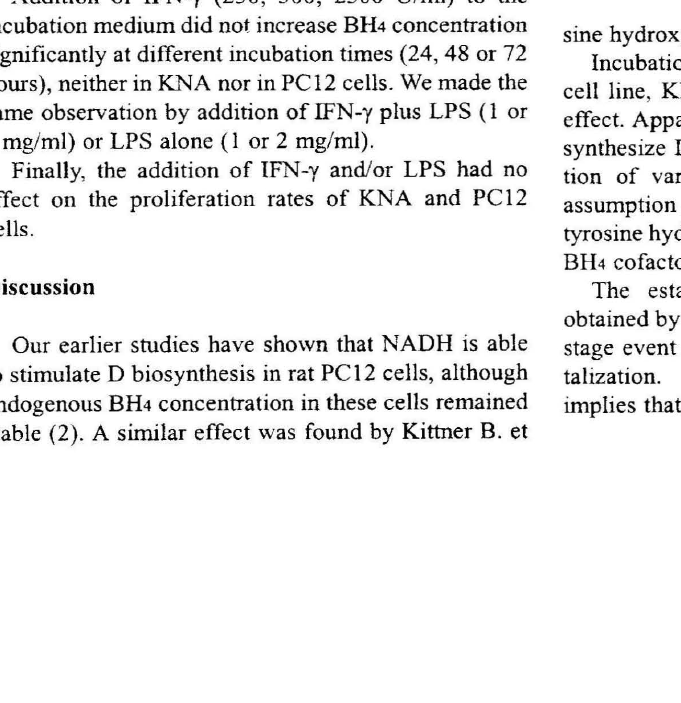
Figure 1. Tetrahydrobiopterin concentrations (nM) of human KNA and rat PC 12 cells after 24 and 72 hours incubation